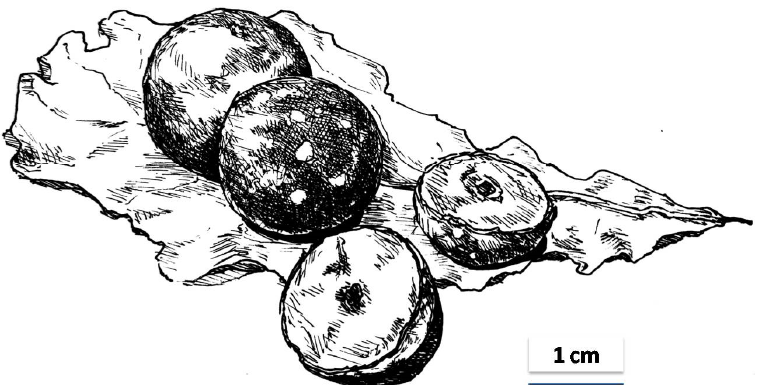
Figure 2. Drawing of mature and bisected oak tree galls, known as oak apples, on an oak leaf.